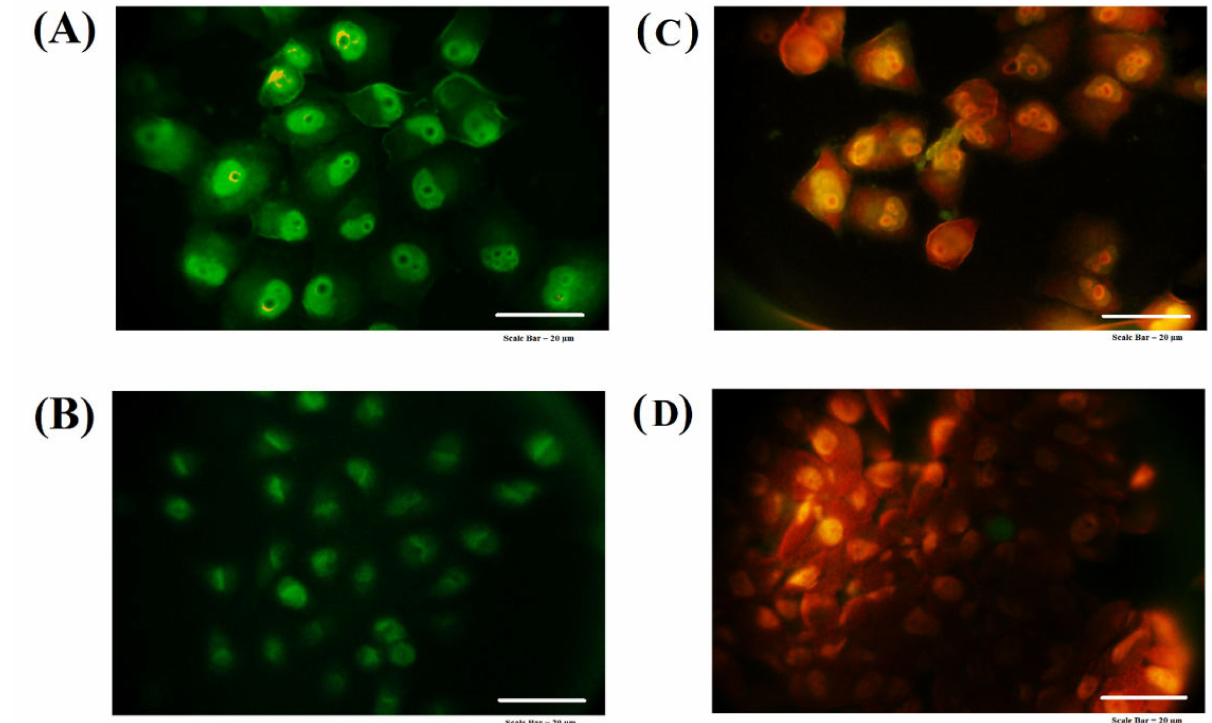
Figure 13. Apoptotic feature detected by acridine orange–ethidium bromide dual staining assay of the MCF-7 cell line (upper lane) and the CAL-51 cell line (lower lane). ( A , B ) Non-treated cells at MCF-7. CAL-51, respectively. ( C , D ) Cells treated with TAM/RES–LbL-LCNPs at MCF-7. CAL-51,